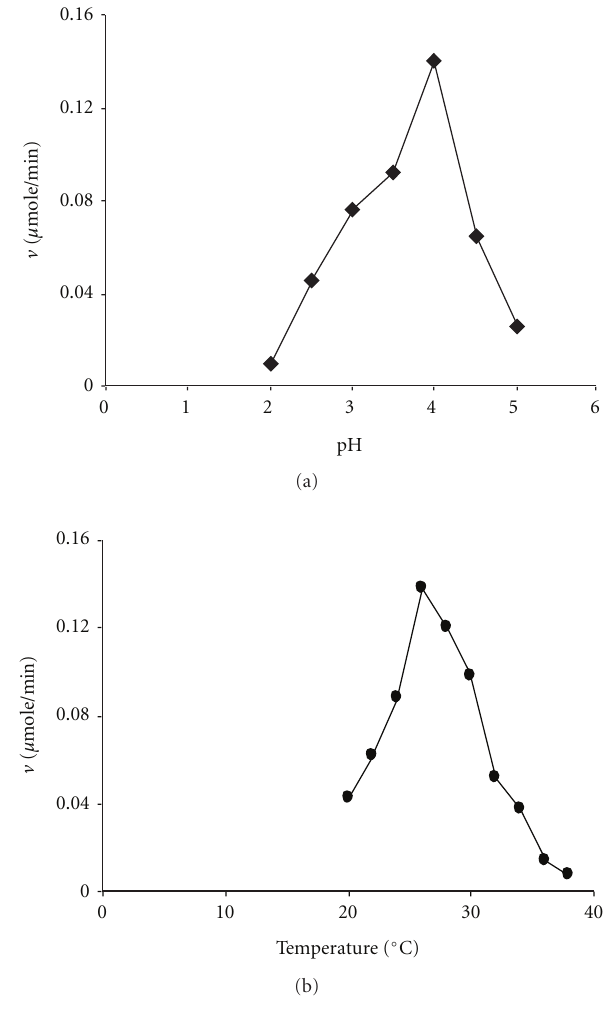
Figure 3: The variation of the activity of the purified enzyme (a) with pH and (b) temperature. The reaction solution 1 mL contained “5 μ g of the enzyme (specific activity 4IU/mg), 100 μ M H 2 O 2 , 100 μ M MnSO 4 in 50mM lactic acid sodium lactate bu ff er.” In (a) pH of the bu ff er was varied at the fixed temperature of 30 ◦ C. In (b) the temperature of the reaction solution was varied at fixed pH of 4.5.